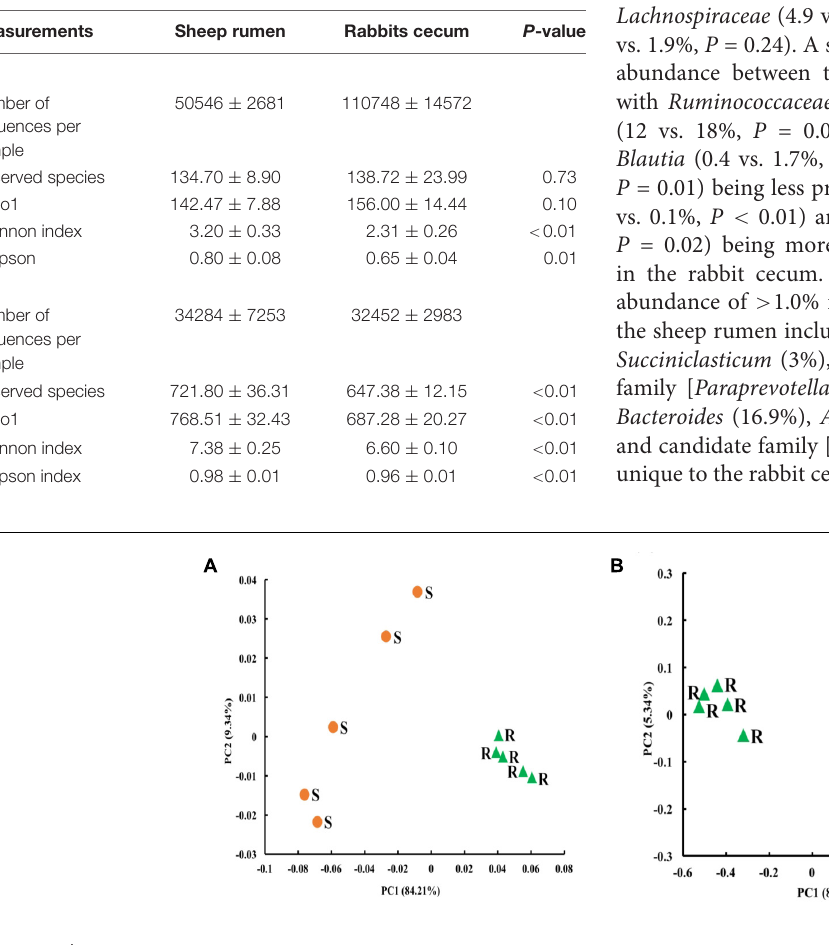
Frontiers in Microbiology |